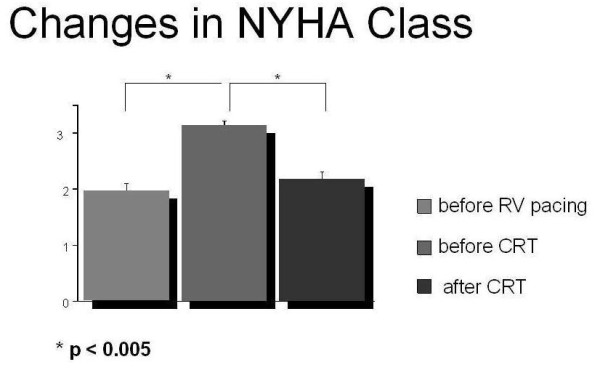
NYHA Class data in the studied patients before RV implantation, before CRT and at FU are reported in the figure.